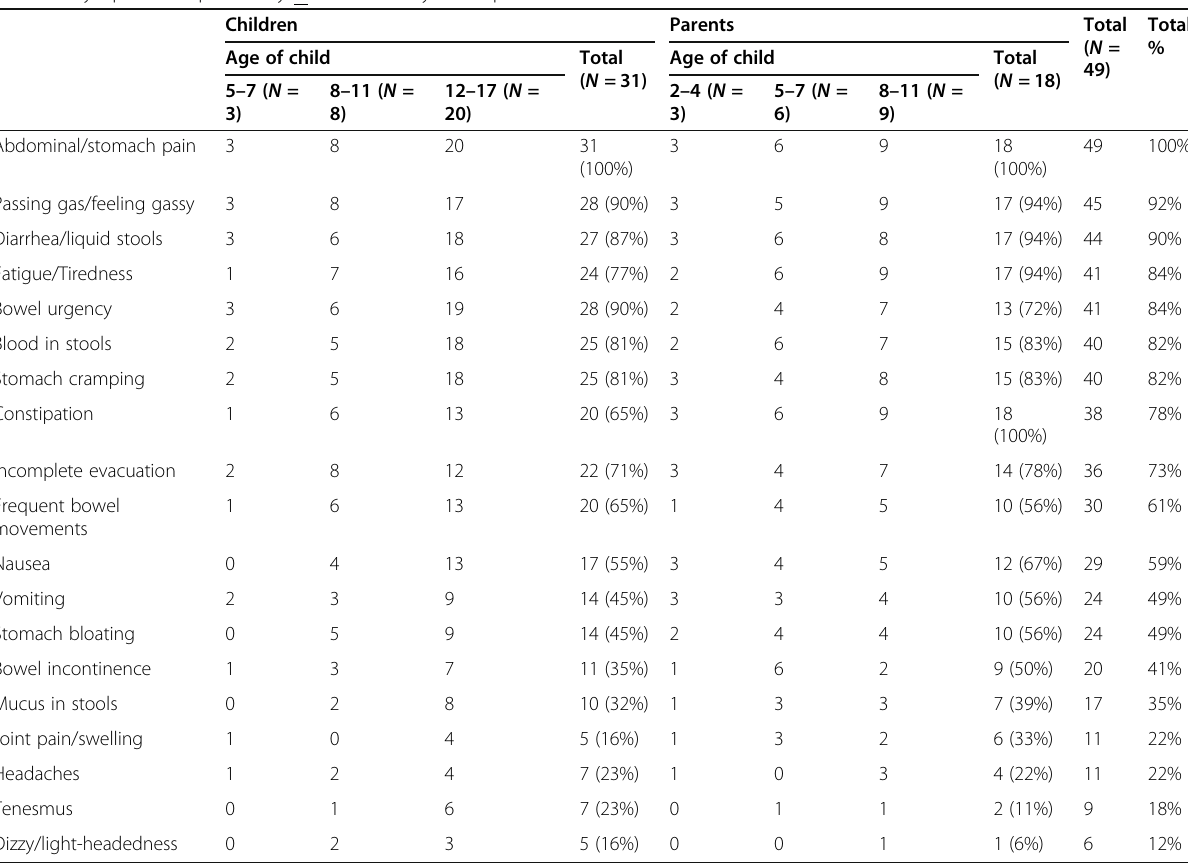
Table 3 Symptoms Reported by > 10% of Study Participants